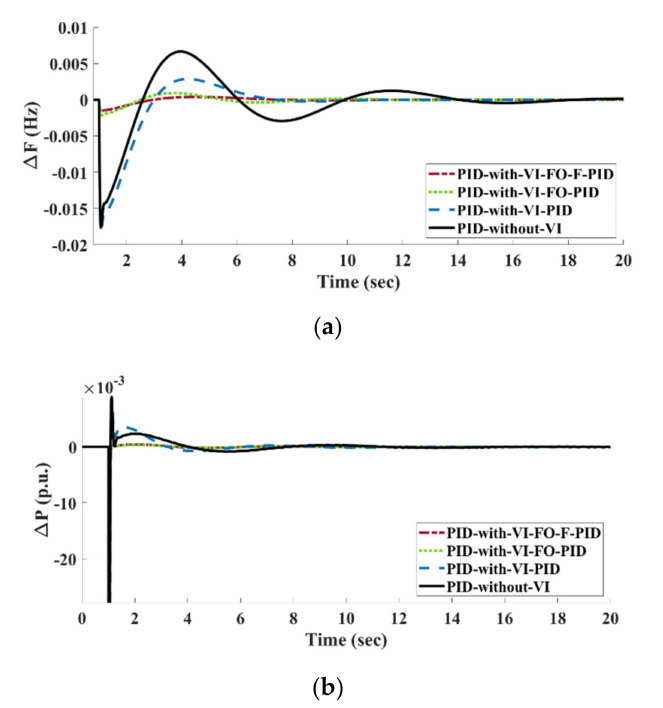
Figure 6. Dynamic response of HPSREG for 10% step increase in load demand ( a ) ∆ F ( Hz ) and ( b ) ∆ P ( p . u . )